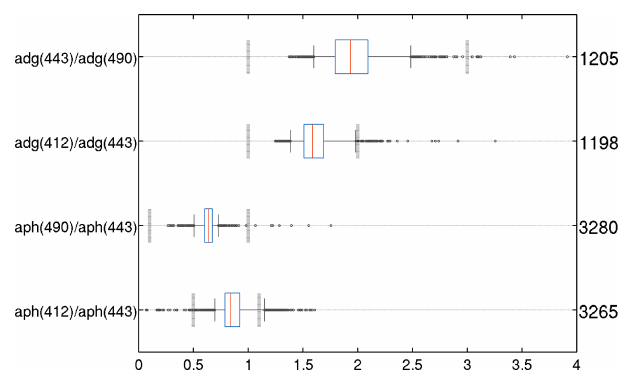
Figure 13. The distribution of absorption coefficients band ratios: adg(443) / adg(490), adg(412) / adg(443), aph(490) / aph(443) and aph(412) / aph(443). Data within 2nm of the wavelengths were used. The graphical convention is identical to Fig. 2. The vertical dashed lines show the lower and upper thresholds used for qual- ity control in the IOCCG report 5. The total number of points for adg ratios are divided between NOMAD (89%), COASTCOLOUR (7%), MERMAID (3%) and SeaBASS (1%). The total number of points for aph ratios are divided between NOMAD (36%), TPSS (29%), COASTCOLOUR (18%), AWI (14%), MERMAID (2%) and SeaBASS